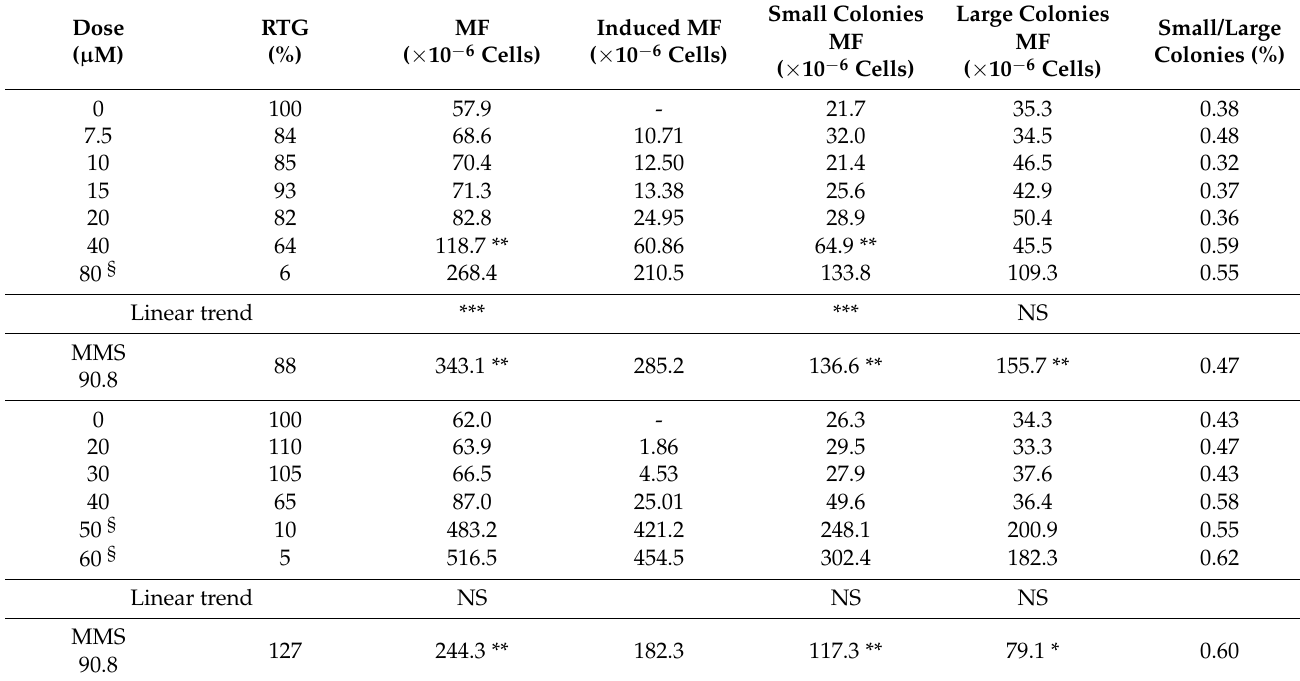
Table 2. Tk + / Tk − mutations induced by 24 h exposure to BDA in L5178Y